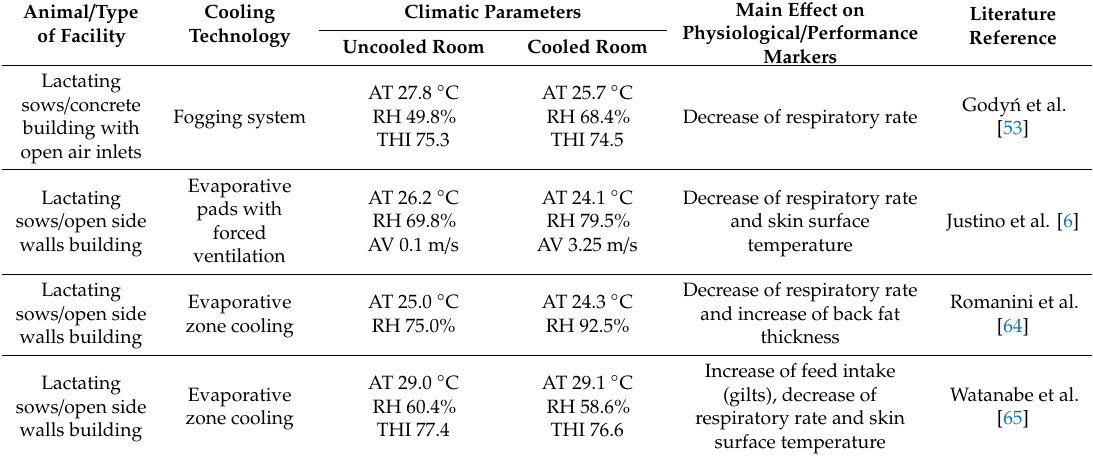
Table 1. Impact of cooling methods on climatic and physiological parameters in